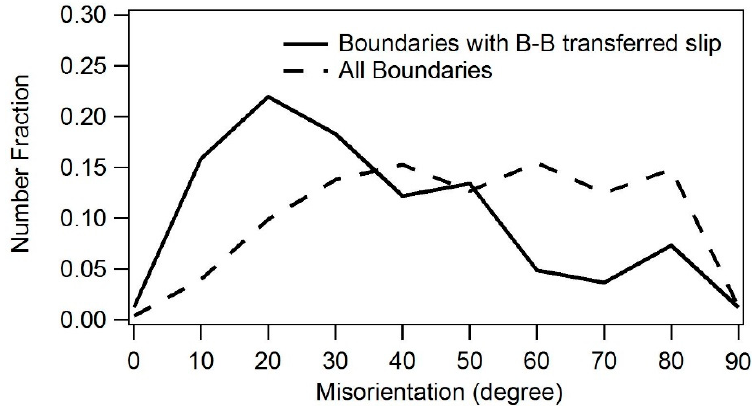
Figure 9. Relationship between misorientation angle and number fraction of B–B transferred slip.